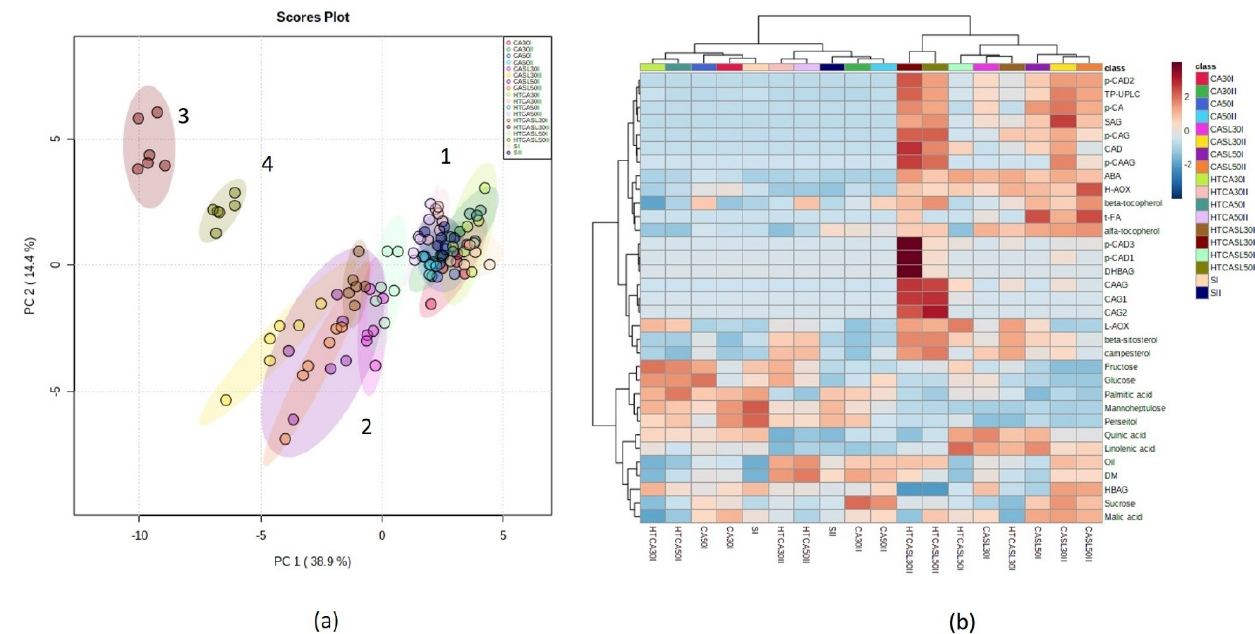
Figure 1. Principal component analysis of the complete dataset, including early and middle harvest fruit. ( a ) Score plot and ( b ) heat map based on hierarchical cluster analysis based on Euclidean distance and Ward algorithm with the 33 significant metabolites revealed by ANOVA followed by the Tukey test ( p < 0.05). Samples correspond to different treatments, harvest stages, storage times, and corresponding edible ripeness stages. Samples corresponding to the different conditions are on the horizontal axis, and the abundance of the different metabolites and analysis are represented on the vertical axis. SI = Initial day early harvest fruit; SII = Initial day middle harvest fruit; CA30I and CA50I = controlled atmosphere for 30 and 50 days early harvest; CA30II and CA50II = controlled atmosphere for 30 and 50 days middle harvest; CASL30I and CASL50I = controlled atmosphere for 30 and 50 days early harvest after shelf-life period; CASL30II and CASL50II = controlled atmosphere for 30 and 50 days middle harvest after shelf-life period; HTCA30I and HTCA50I = hydrothermal treatment for 30 and 50 days early harvest; HTCA30II and HTCA50II = hydrothermal treatment for 30 and 50 days middle harvest; HTCASL30I and HTCASL50I = hydrothermal treatment for 30 and 50 days early harvest after shelf-life period; HTCASL30II and HTCASL50II = hydrothermal treatment for 30 and 50 days middle harvest after shelf-life period. Average of 6 replicates is displayed. DM = dry matter, ABA = abscisic acid, H-AOX = hydrophilic antioxidant activity, L-AOX = lipophilic antioxidant activity, DHBAG = dihydroxybenzoic acid glycoside, SAG = syringic acid glycoside, CAG1 = caffeic acid glycoside 1, CAG2 = caffeic acid glycoside 2, HBAG = hydroxybenzoic acid glycoside, p -CAG = p -coumaric acid glycoside, CAD = caffeic acid derivative, p -CAD1 = p -coumaric acid derivative, CAAG = caffeic acid acetilglycoside, p -CA = p -coumaric acid, p -CAAG = p -coumaric acid acetylglycoside, p -CAD2 = p -coumaric acid derivative, t -FA = trans-ferulic acid, p -CAD3 = p -coumaric acid derivative.